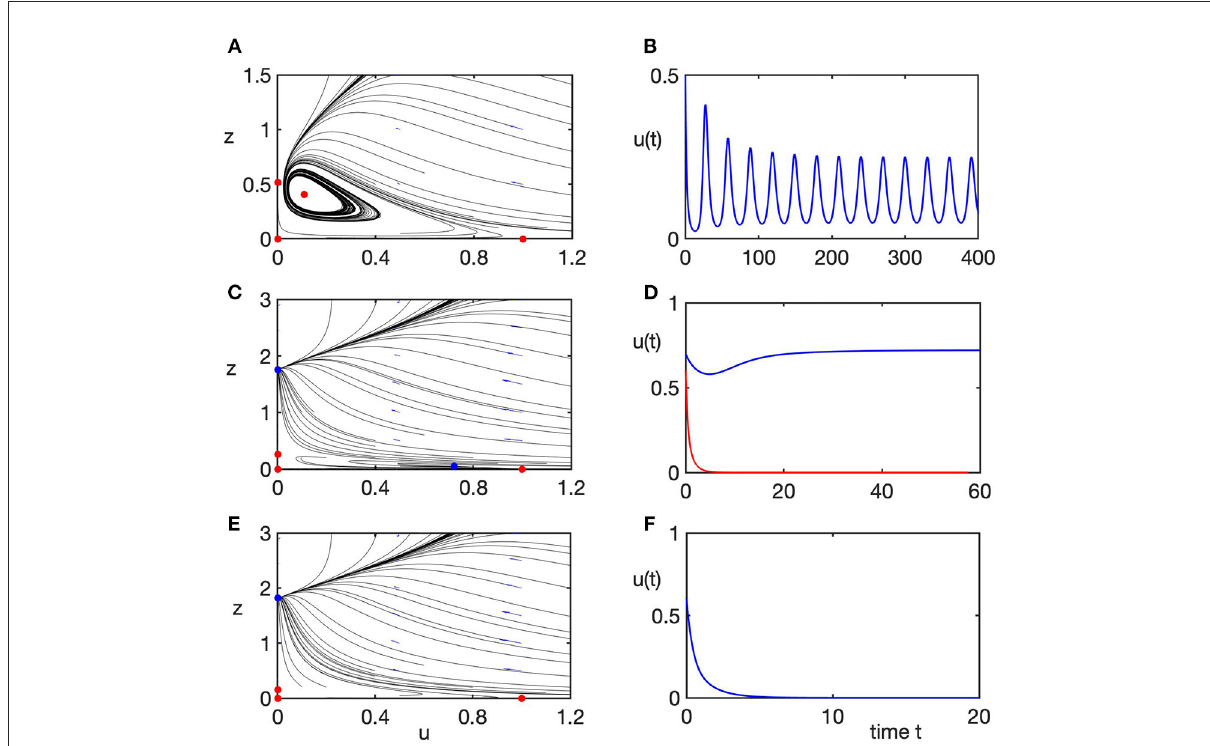
FIGURE5 Phase planes (left column) of the transformed system (Equation 5) and the corresponding numerical solution (right column) of the rescaled original system (Equation 4), illustrating different dynamical regimes listed in Figure 3A. Blue/red dots in phase plane plots indicate stable/unstable steady states. Parameter values are α = d = 1. (A,B) Case 4, a = 3.3, b = 1.5, periodic solution around the unstable coexistence steady state E ∗ . (C,D) Case 5, a = 6, b = 1.05, bi-stability between the extinction steady state E 0 and the coexistence steady state E ∗ . (E,F) Case 6, a = 6, b = 1.4, only the extinction steady state E 0 is